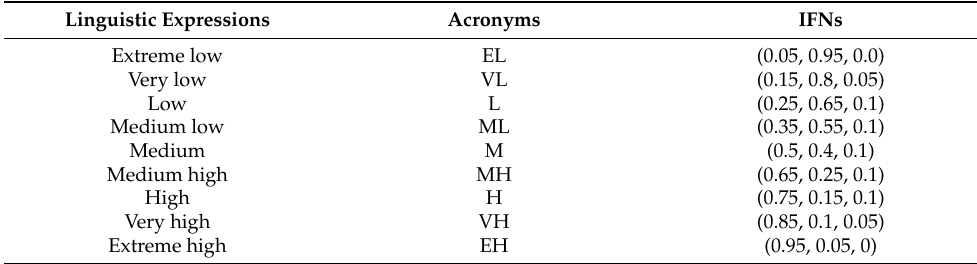
Table 3. Intuitionistic fuzzy numbers and corresponding linguistic terms for pairwise comparison. Linguistic